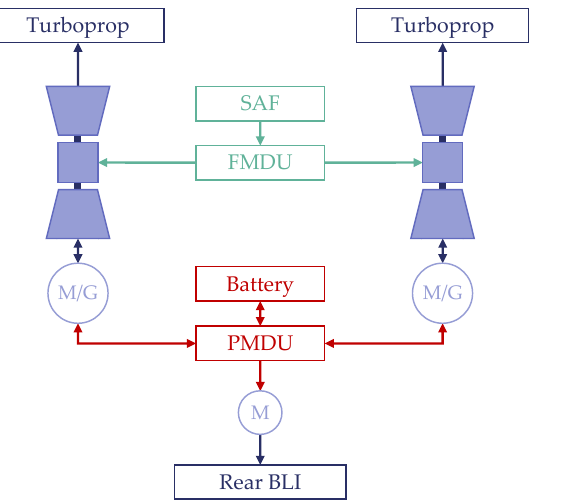
Figure A3. Architecture 3: Parallel hybrid-electric architecture with electric boosters and